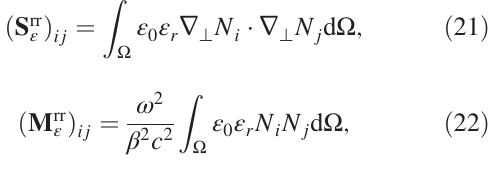
FIG. 3. Horizontal dipole source term σ ð x; y Þ in arbitrary